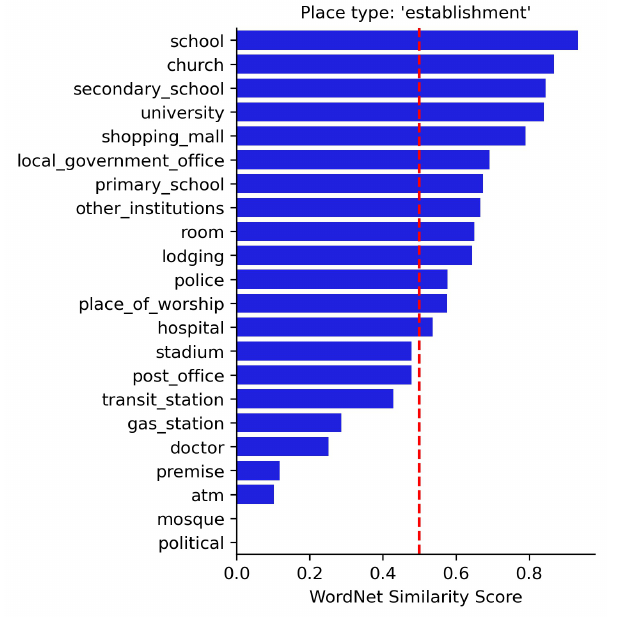
Figure 8. WordNet similarity scores between ‘establishment’ place type in data source C and various place types in D ref